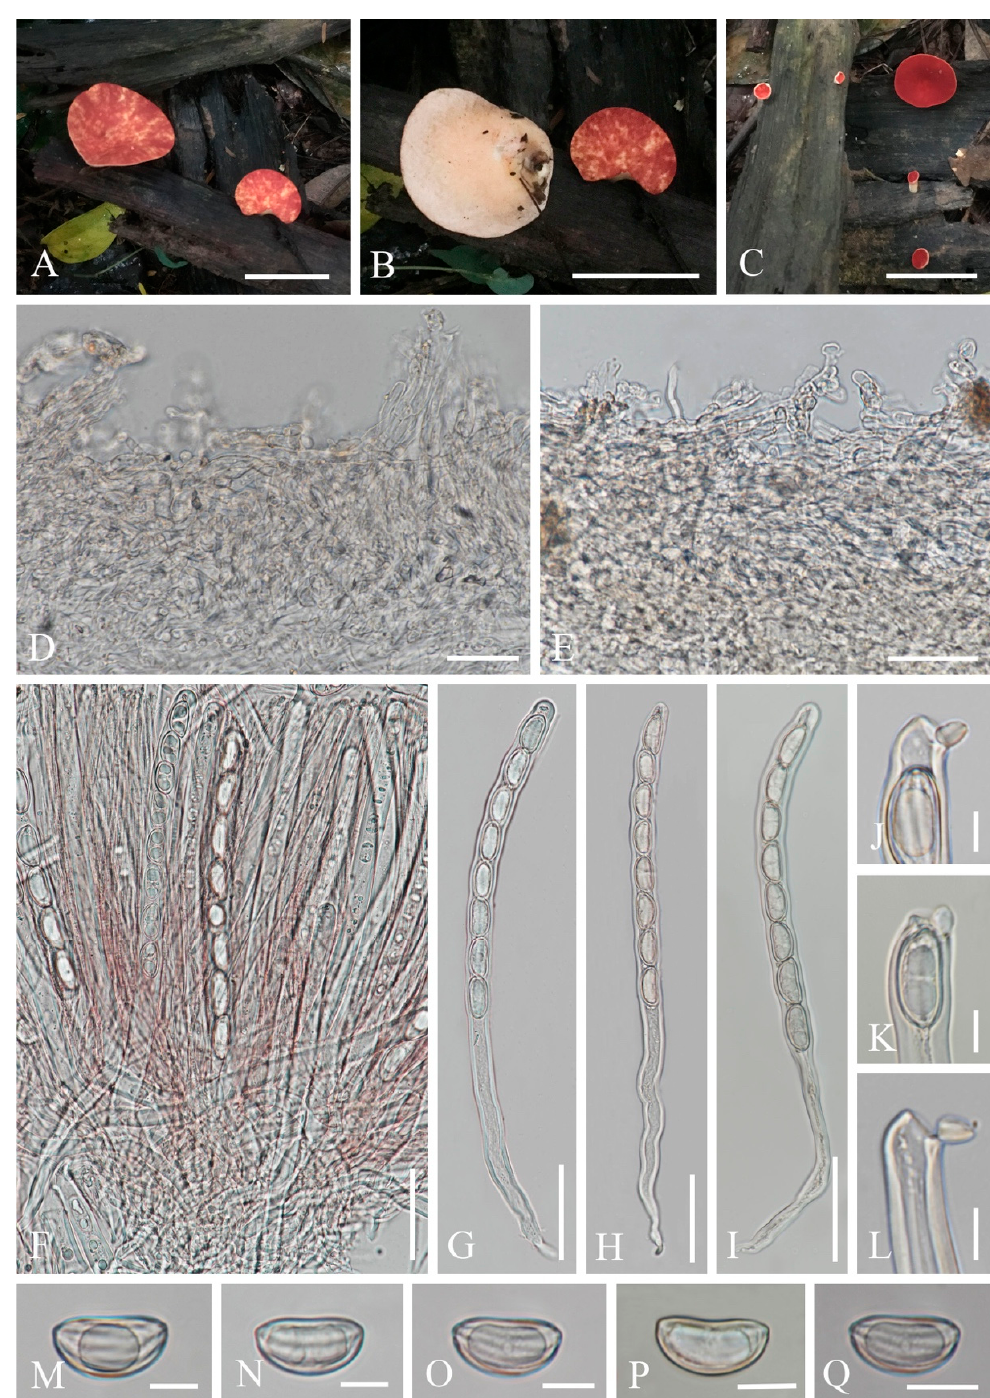
Figure 14. Phillipsia domingensis . ( A – C ) Fresh apothecia [( A , B ) HKAS 121193. ( C ) HKAS 121192.] ( D ) Vertical section of stipal ecto ‐ excipulum. ( E ) Vertical section of ectal excipulum. ( F ) Hymenium. ( G – I ) Asci and ascospores. ( J – L ) Asci apices. ( M – Q ) Ascospores. Scale bars ( A – C ) = 3 cm; ( D , E ) = 30 μ m; ( F – I ) = 50 μ m; ( J – Q ) = 10 μ m.